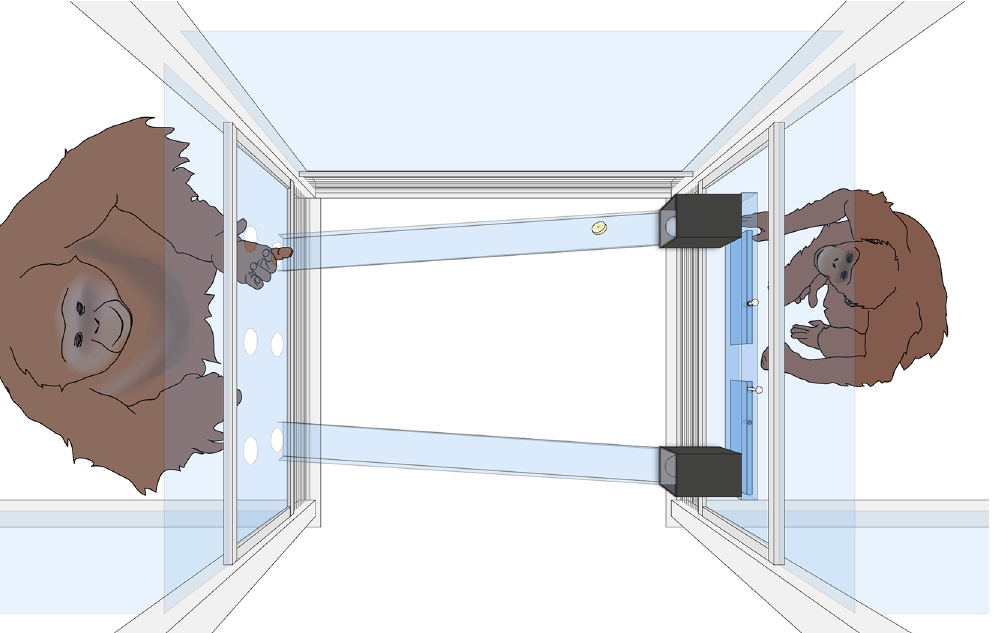
Fig 1. An Illustration of the Equipment Used in the Communication Game. The communicator on the left could see but not obtain the banana pellet hidden in one of the black boxes. The donor on the right could release the food to the communicator, but could not see its location for herself. However, the communicator could potentially indicate the location of the food by pointing through either the top or bottom row of holes on the opposite panel. A locking mechanism prevented the donor from releasing more than one side per